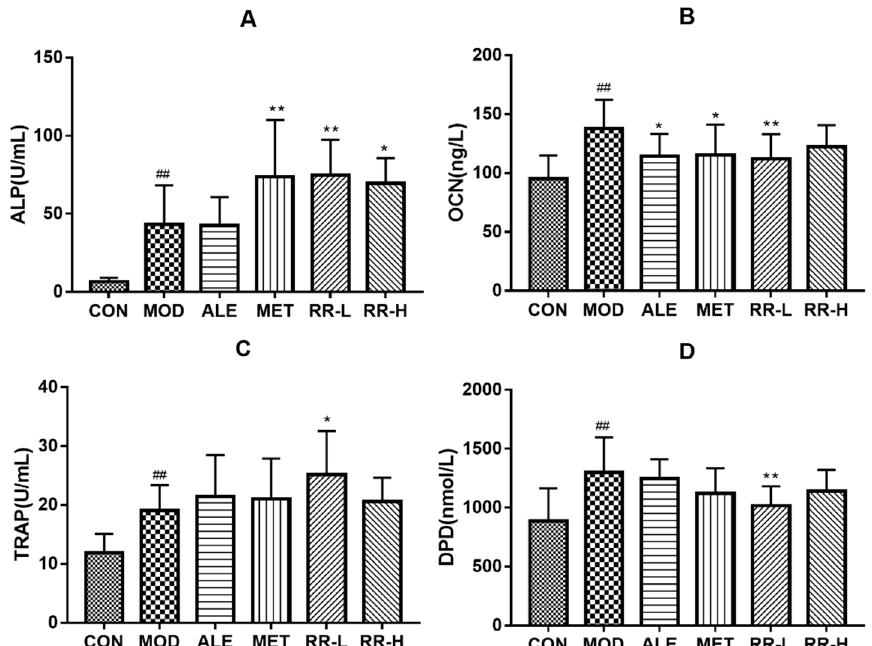
Figure 2. E ff ects of RR on biochemical parameters related to bone metabolism in diabetic rats after 8-week oral administration. ( A ) Serum alkaline phosphatase (ALP) activity. ( B ) Serum osteocalcin (OCN)level. ( C )Serumtartrate-resistantacidphosphatase(TRAP)activity. ( D )Urinedeoxypyridinoline (DPD) level. All data are expressed as the mean ± SD ( n = 10). ## p < 0.01 as compared with the control group, and * p < 0.05 and ** p < 0.01 as compared with the model